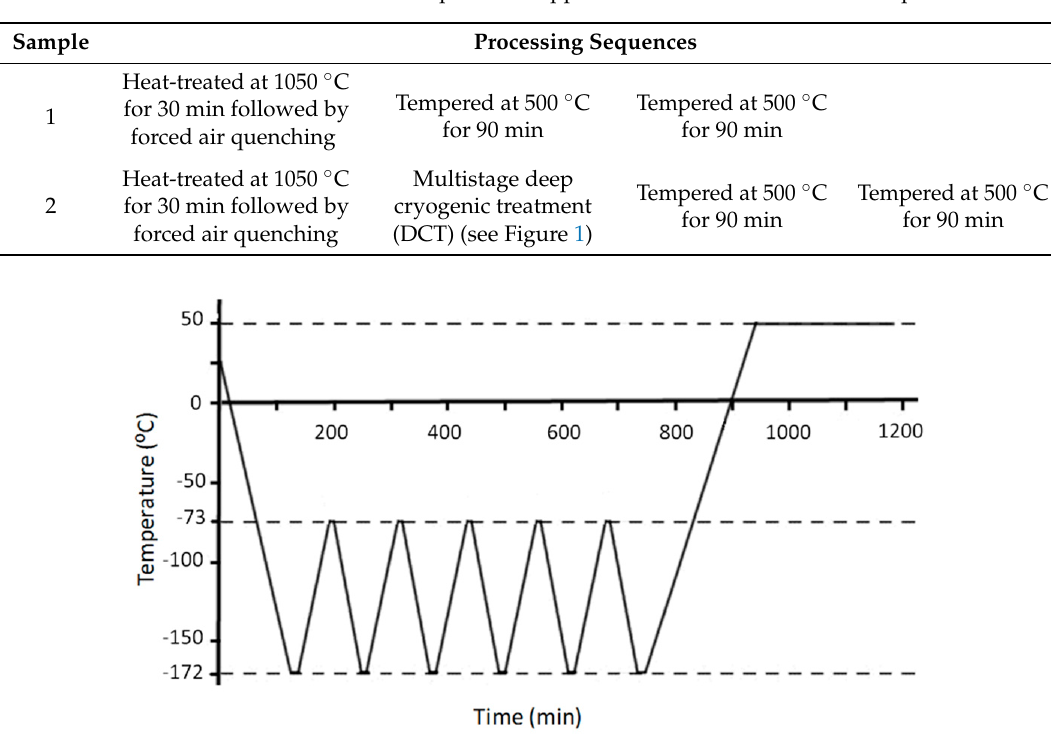
Table 2. Different heat treatment processes applied to the AISI A8 tool steel samples.